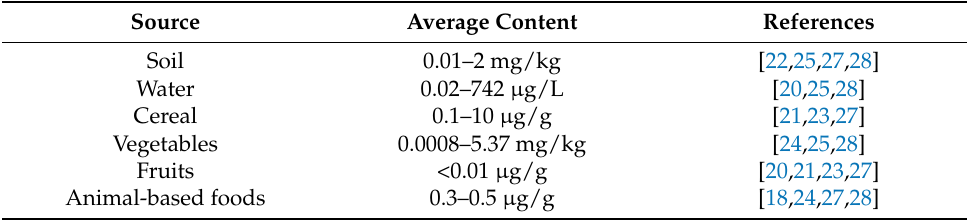
Figure 1. Different organs are regulated by different selenoproteins. Se plays an important role in maintaining body health and can regulate body health through oxidative stress and immune regulation. Se usually exists in the form of selenite, Secys, SeMet and selenate. Se is absorbed in the body mainly in the form of selenoproteins. GPX1 and GPX2 can regulate body health by mediating the production of reactive oxygen species. SELENOP can be expressed as a plasma transporter in various organs, and it is downregulated in cancer and IBD. DIO1 can affect the metabolism and activity of thyroid hormones. DIO1 deficiency contributes to kidney cancer, and DIO1 overexpression inhibits the proliferation and migration of renal cancer cells. SELENOI regulates body health through the nervous system. Loss of SELENOI promotes neurodegenerative diseases such as Alzheimer’s disease and hereditary spastic paraplegia. Table 1. The distribution of Se content in environment and